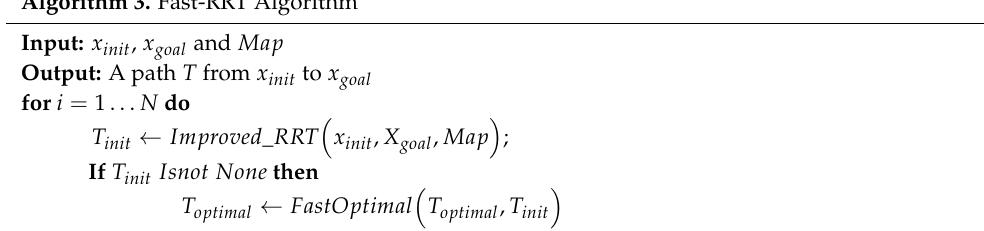
Algorithm 3. Fast-RRT Algorithm